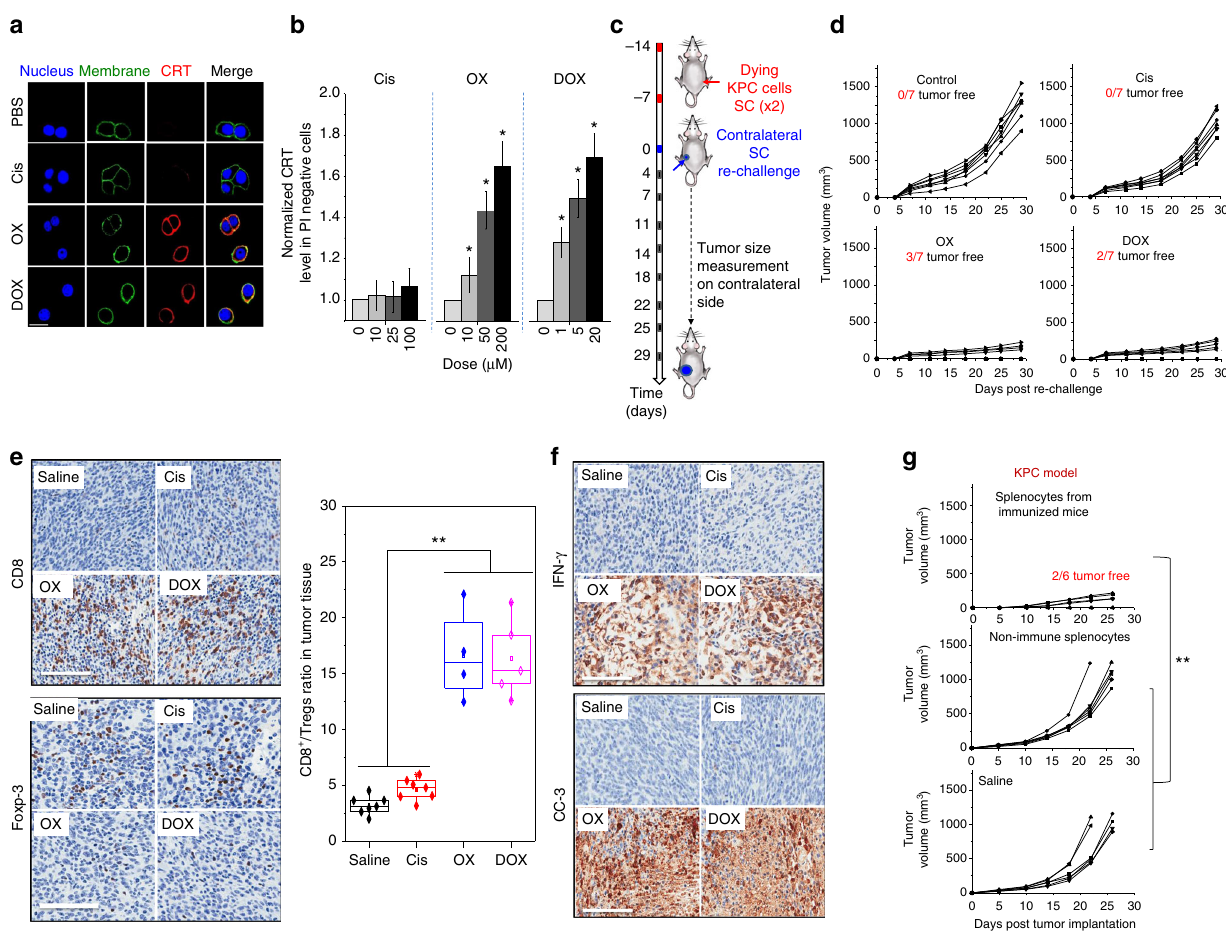
Fig. 2 Oxaliplatin-induced ICD provides a successful anti-PDAC vaccination approach. a Confocal microscopy showing the induction of the ICD marker, CRT, in KPC cells in the presence of PBS, Cis (100 µ M), OX (50 µ M), and DOX (1 µ M) for 4 h. The cell nuclei, surface membrane and CRT were detected by Hoechst 33342, Alexa Fluor ® 488-Conjugated Wheat Germ Agglutinin, and Alexa Fluor ® 647-conjugated anti-CRT antibody staining, respectively. Scale bar is 20 μ m. b CRT surface detection by fl ow cytometry, using the same conditions and reagents as in a (3 independent experiments). c Animal experimentation using 2 rounds of vaccination one week apart, followed by injecting live KPC cells SC on the contralateral side. The details of the animal vaccination experiment are provided in the methods section. Tumors were collected on day 29 for IHC and fl ow cytometry analysis. d Spaghetti curves to show KPC tumor growth in the contralateral fl ank. e Tumor collection was performed after euthanizing the animal to conduct IHC. Representative images are shown for the IHC staining of CD8 (upper panel) and Foxp3 (lower panel) T cells. The tumor tissues were also analyzed by fl ow cytometry to determine the CD8/Tregs ratio (see experimental section for details) (right panel). f IHC staining for cleaved caspase-3 (CC-3) and IFN- γ to demonstrate recruitment of cytotoxic T cells in response to ICD. Scale bar in IHC is 100 μ m. g The 3 surviving animals in the OX-treated group, described in c , received orthotopic implant of live KPC cells on day 74. Animals maintained their tumor-free status up to 132 days, whereupon they were euthanized for collecting the immune splenocytes to perform an adoptive transfer experiment. IV injection of the immune splenocytes into the tail vein of B6/129 mice prevented the growth of KPC cells, implanted SC. The controls included IV administration of non-immune splenocytes or saline. The same experiment was also carried out in mice receiving SC injection of B16 melanoma cells. In this case, there was no interference in tumor growth by immune splenocytes, demonstrating the antigen speci fi city of the adoptive transfer response (Supplementary Fig. 3). The results are expressed as mean ± SEM. * p < 0.05; ** p < 0.01, (ANOVA)